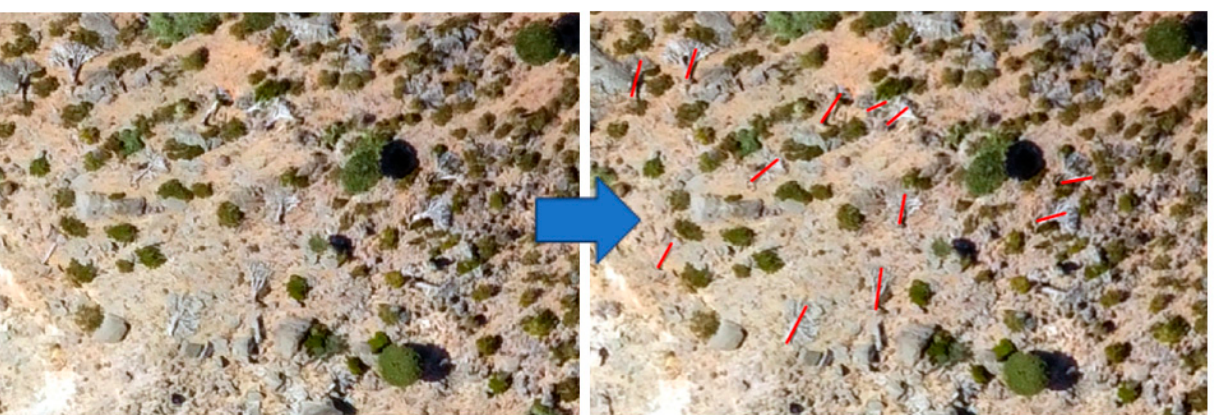
Figure 4. Uprooted Dracaena trees in the study area were visually identified and vectorized manually. Red lines indicate the direction of each fallen tree, added as linear vector